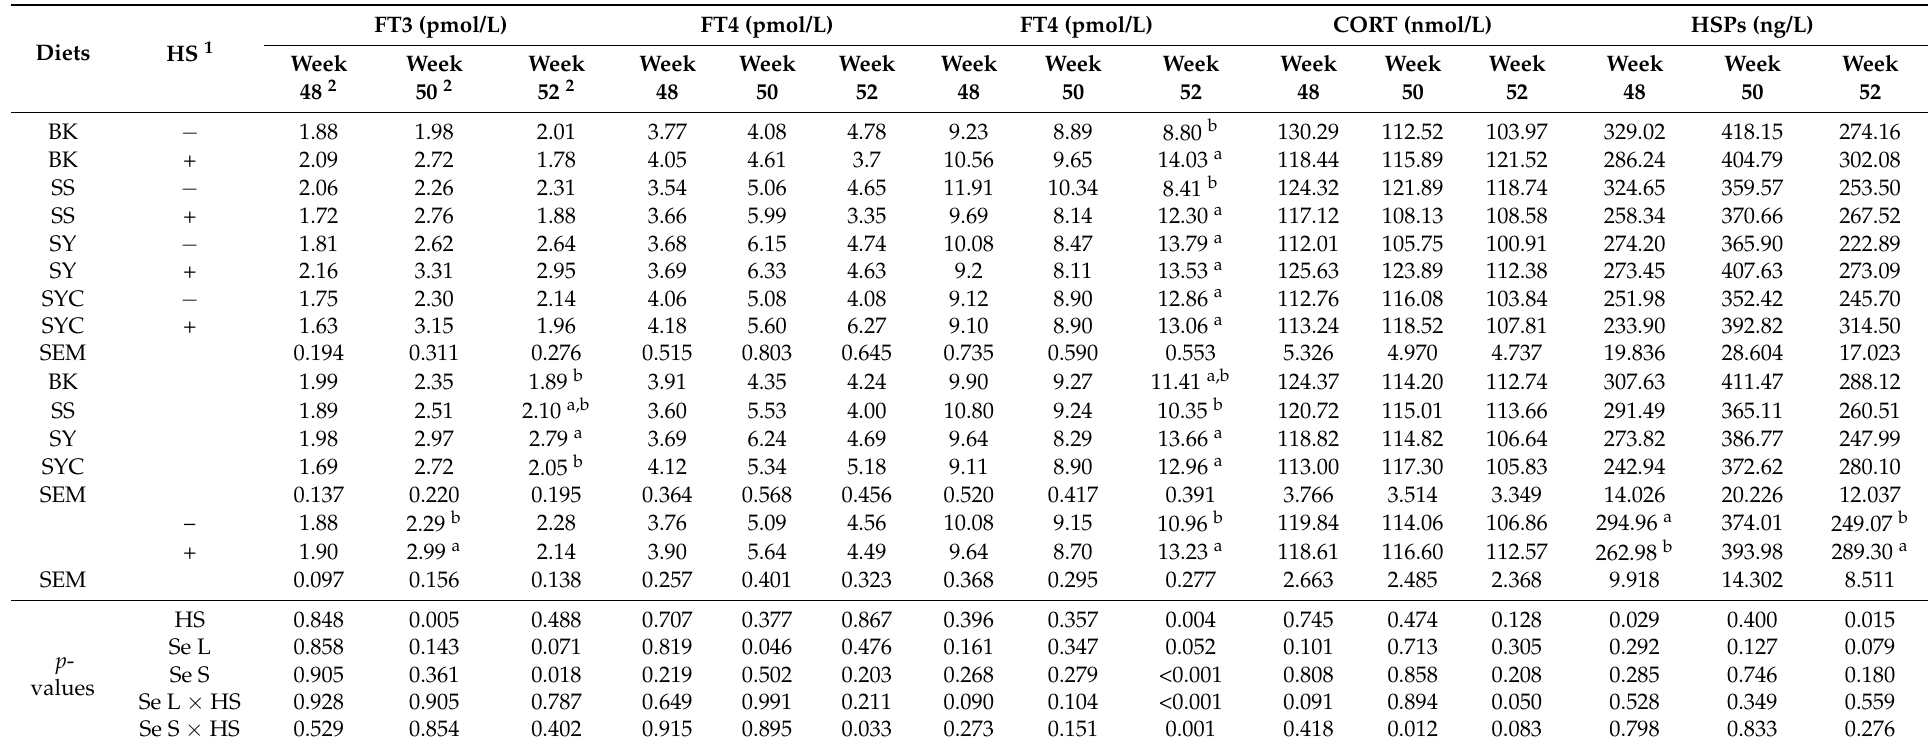
Different letters indicate statistically significant differences ( p < 0.05). BK: basal diet, SS: sodium selenite, SY: selenium yeast, SYC: selenium-enriched yeast culture, FT3: free triiodothyronine, FT4: free thyroxine, DI-I: deiodinase-I, CORT: corticosterone, HSPs: heat stress protein, Se L: selenium levels, and Se S: selenium sources. 1 HS − = Normal